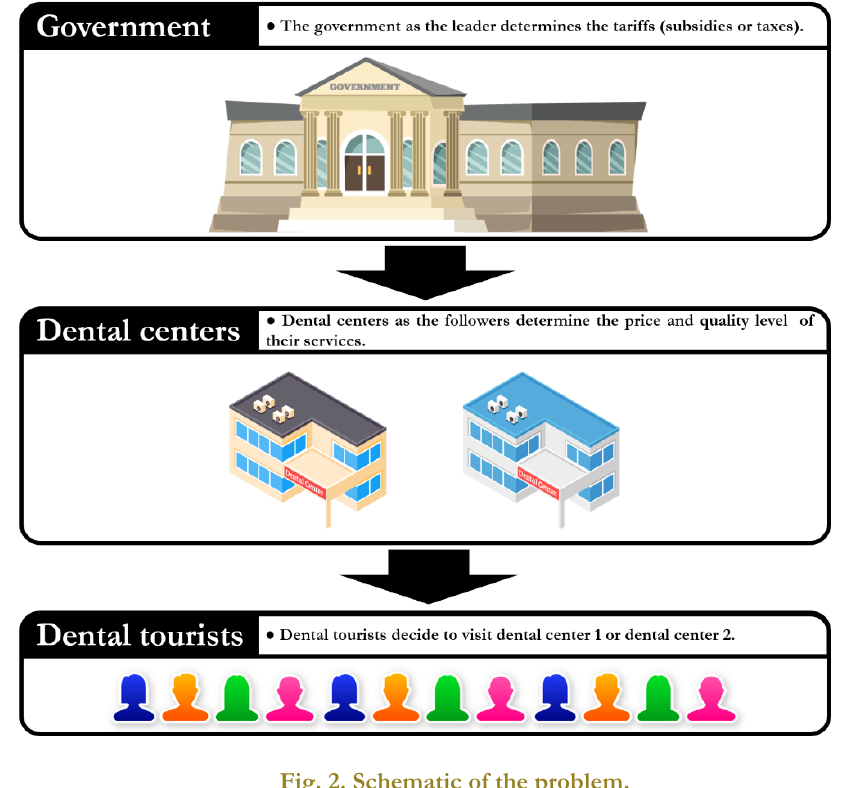
Fig. 2. Schematic of the problem.